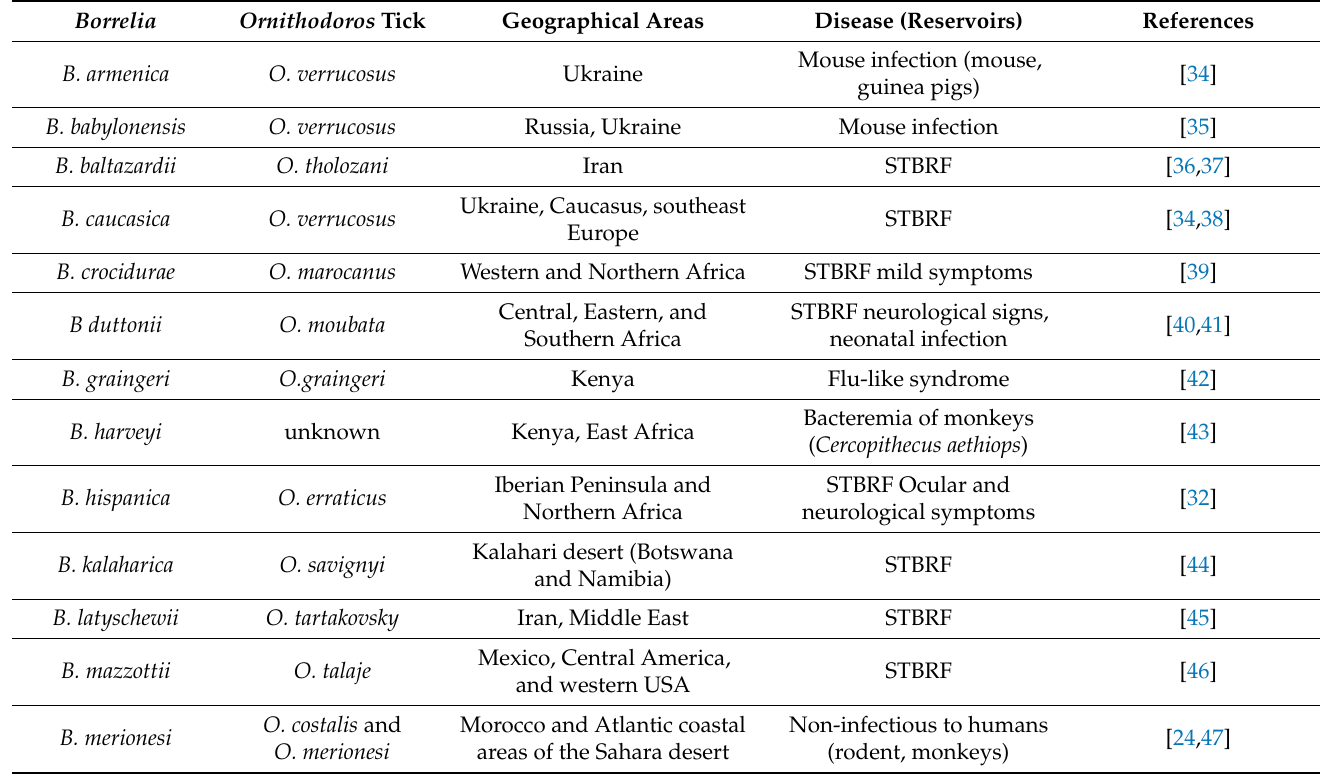
Table 2. Old World soft-tick-borne relapsing fever Borreliae with geographical areas and vectors.